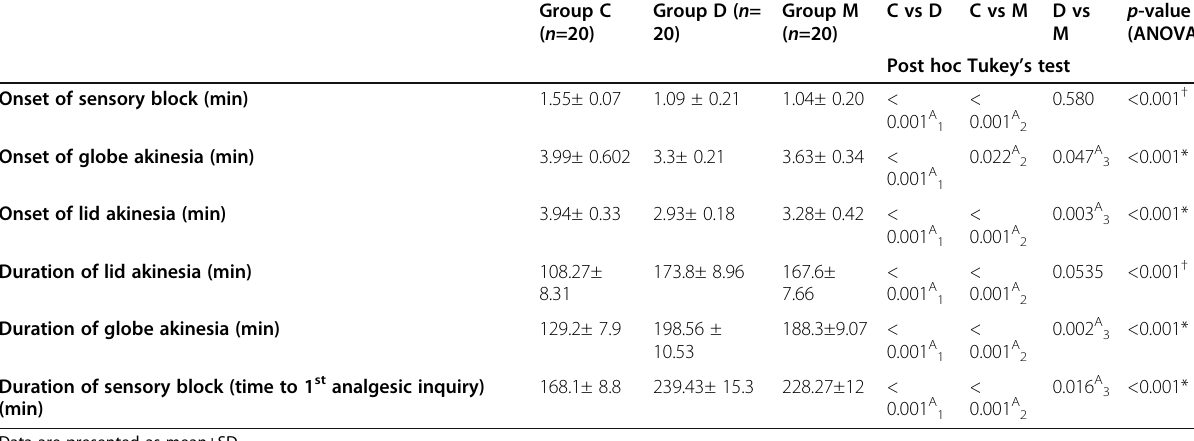
Table 2 Comparison between the three groups regarding the characteristics of the peribulbar block